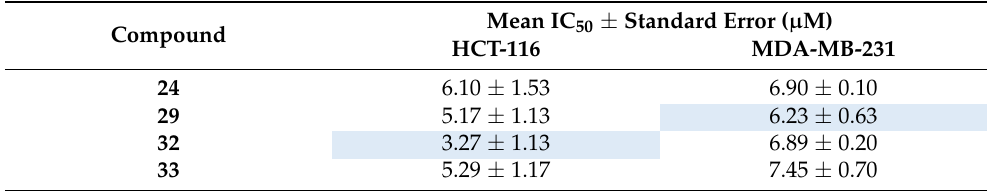
Table 2. IC 50 values. Values are given as the average ± standard error of three experimental replicates. Most active compounds in highlighted